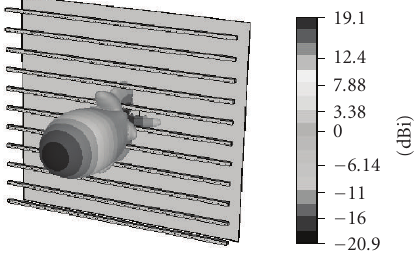
Figure 1: Example of directive EBG antenna.